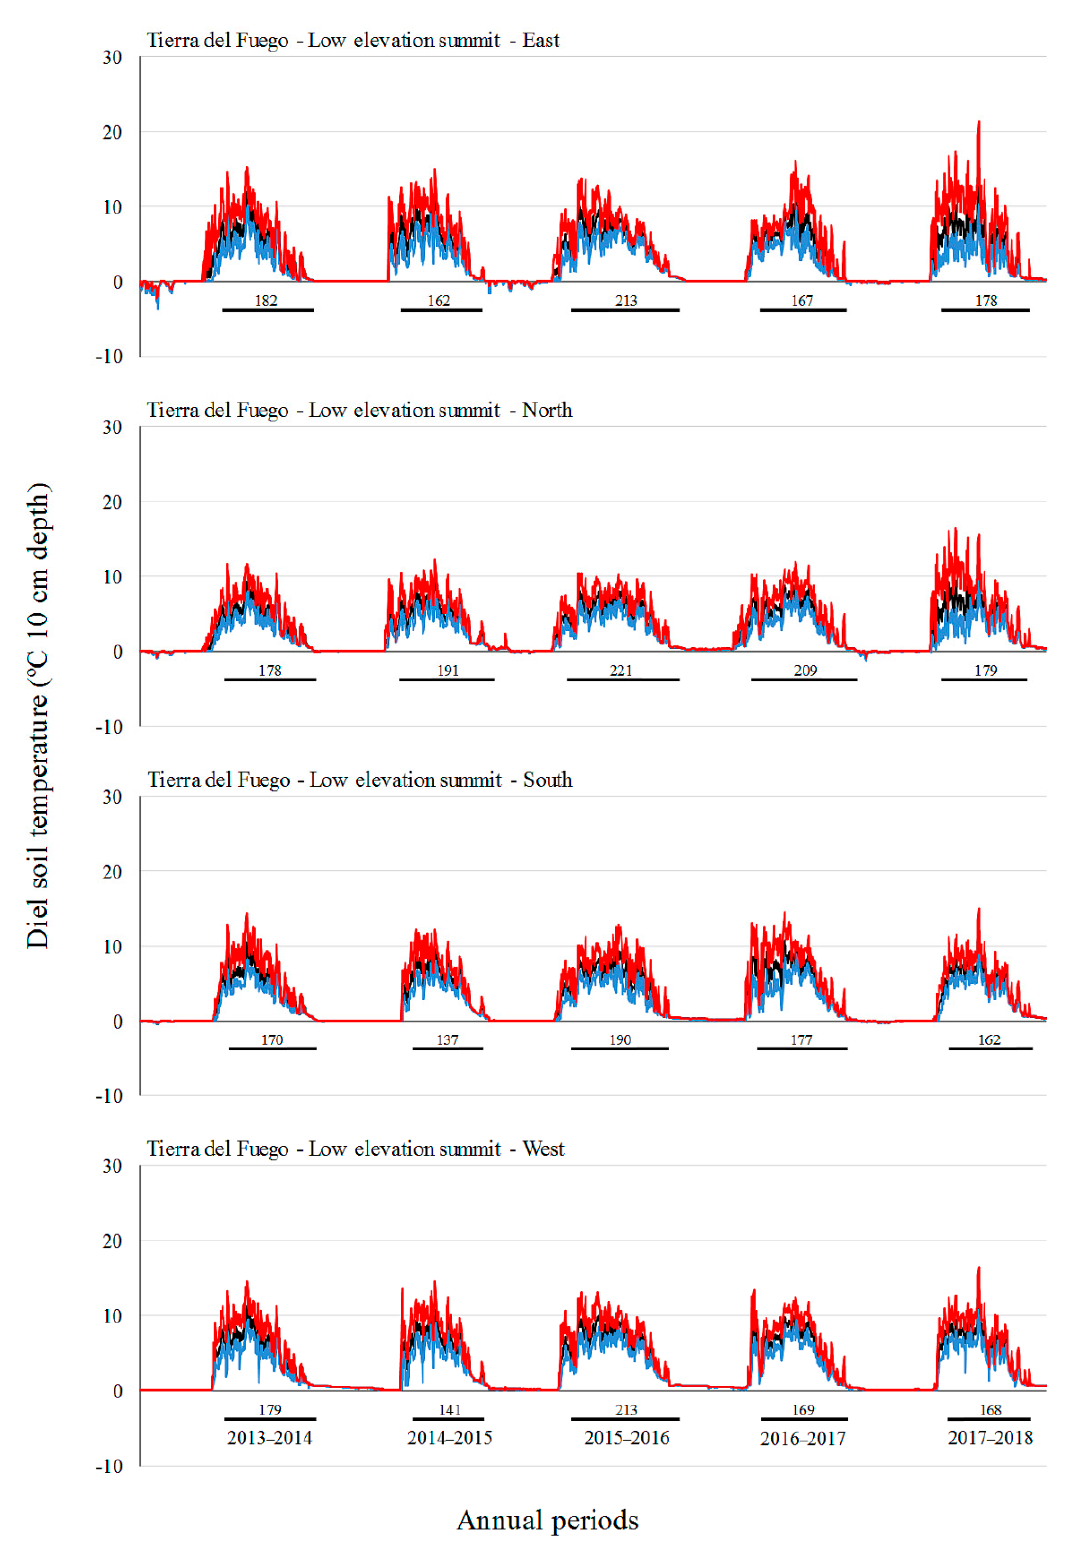
Figure A4. Diel soil temperature ( ◦ C) variation at 10 cm depth during the five studied annual periods (2013–2014 to 2017–2018) on low elevation summit in Tierra del Fuego, showing separately different cardinal aspects (east, north, south, west). The length of the growing season is also indicated with horizontal black bars (numbers represent days). Black = mean temperature; blue = minimum temperature, and red = maximum temperature.